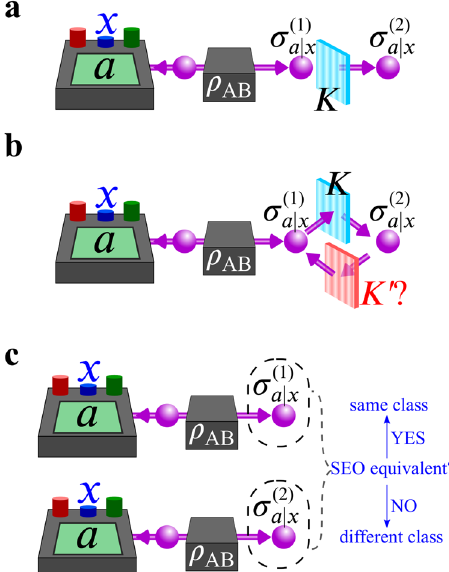
Fig. 1 | Schematic illustration of this work. In this work, we consider three fun- damental quantum information scenarios: that is, distillation, convertibility, and classi fi cation, in a steering-type scenario, where Alice measures her part of the system on state ρ AB and remotely projects Bob's systems into a collection of (subnormalized) states σ a ∣ x . a In the distillation scenario, one asks how much steerability can be distilled by a local fi lter K , that maps σ ð 1 Þ a ∣ x to σ ð 2 Þ a ∣ x . b In the convertibility scenario, one looks for the existence of a fi lter K 0 mapping σ ð 2 Þ a ∣ x back to σ ð 1 Þ a ∣ x . c In the classi fi cation scenario,oneclassi fi es different assemblagesinto the same class if they belong to the same steering-equivalent observable (SEO). By showing the equivalence between the convertibility and classi fi cation problems [scenarios ( b ) and ( c )], we are able to obtain the optimal fi lter that distills